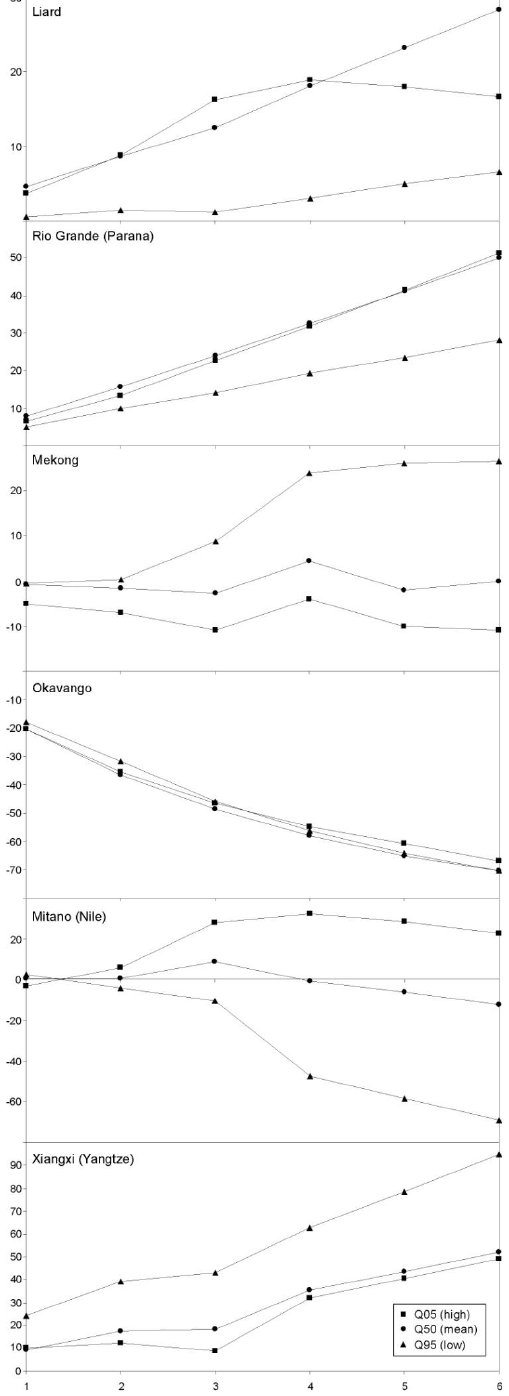
Fig. 2. Projected 30-yr change in river flow (% change from 1961– 1990 baseline) for the study basins as a function of global mean temperature increase, with driving climate data from the HadCM3 GCM.